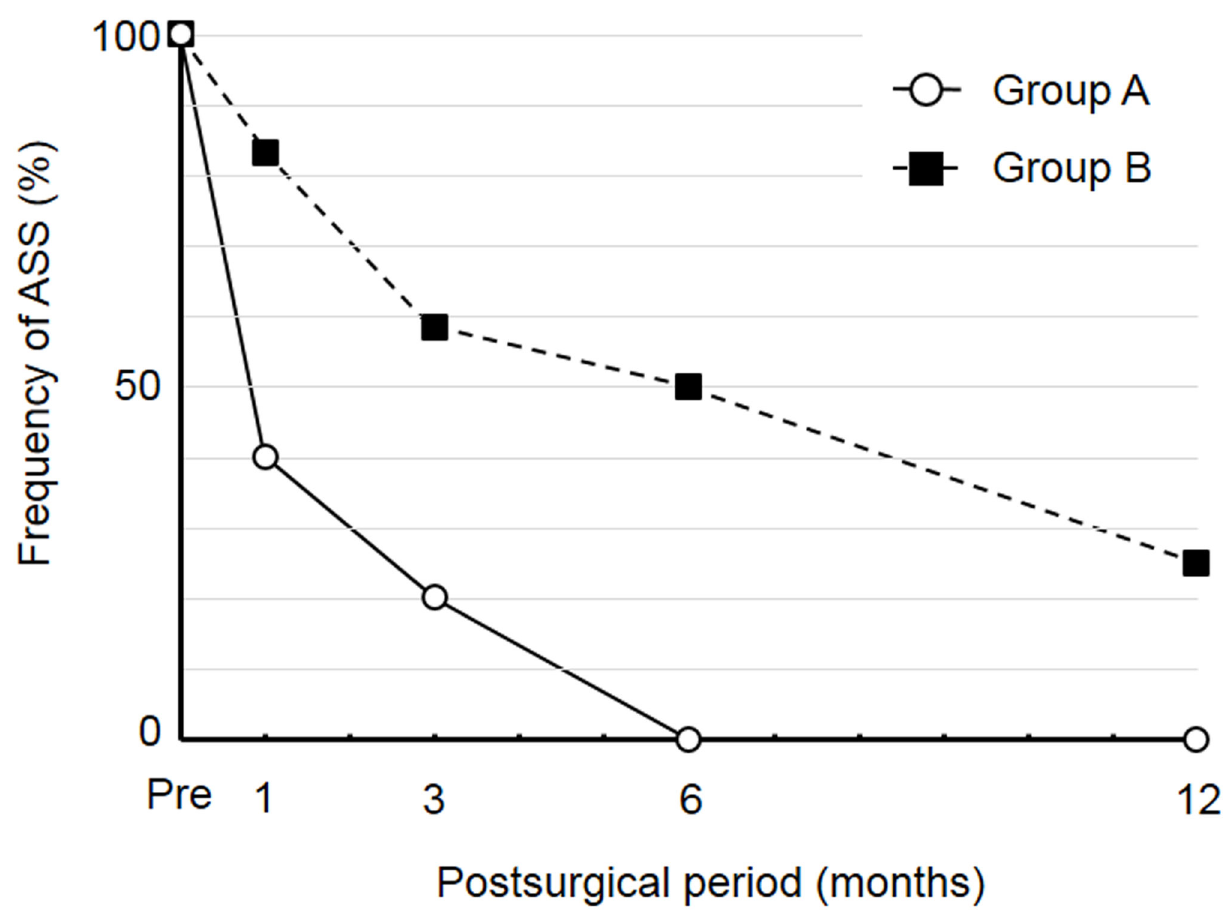
Figure 5. Frequency of ASS in groups A and B before and after DSAEK.